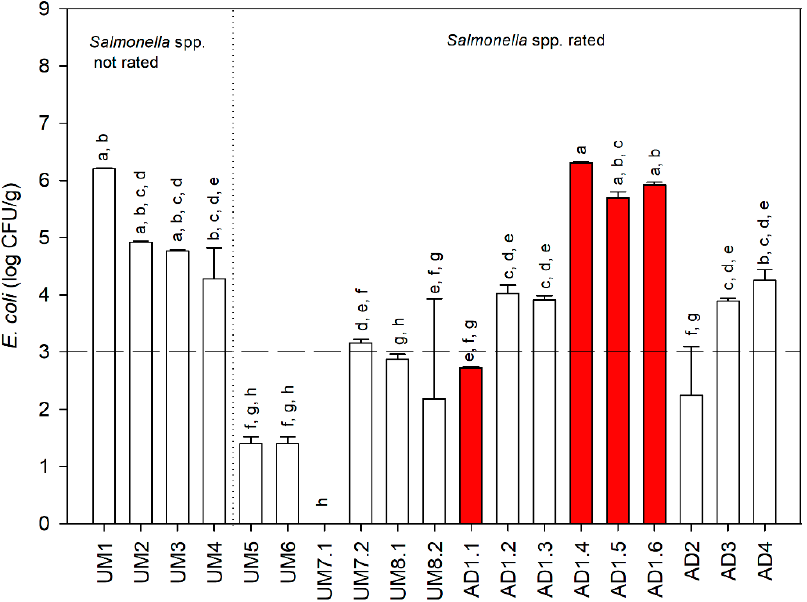
Figure 1. Enumeration of E. coli and absence / presence of Salmonella spp. (Results marked with the same letters are statistically similar (Tukey HSD test with p < 0.05); red bars correspond to the presence of Salmonella spp.).